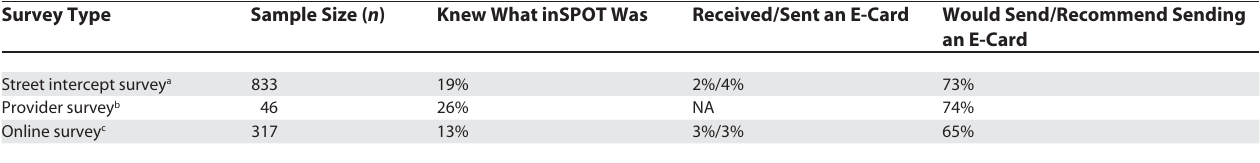
Table 1. Summary of Various Samples of inSPOT Awareness, 2005–2006 Survey